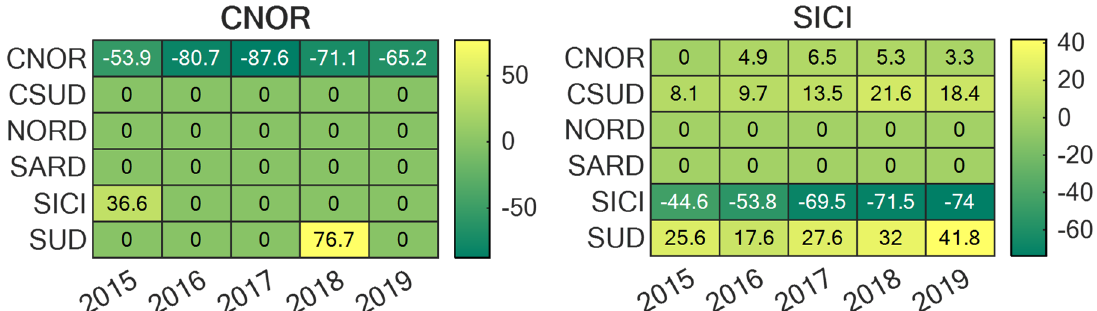
Figure 6. Heatmap chart of the impact of 100 MW increases in wind generation in CNOR and SICI on the net input flow (MW); results of Equations (1) and (2).